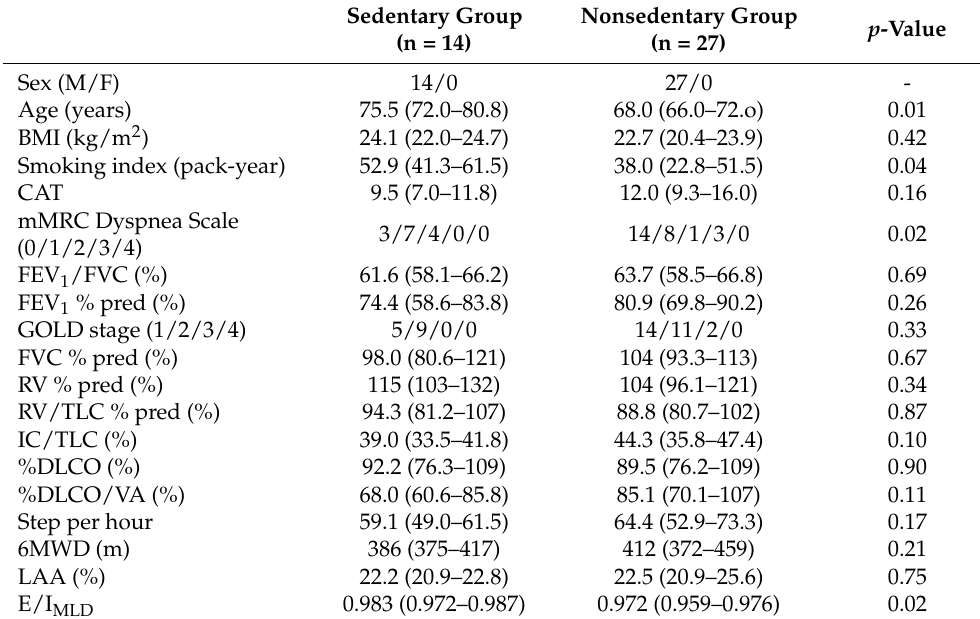
Table 3. Comparison between sedentary and nonsedentary groups of patients with COPD.